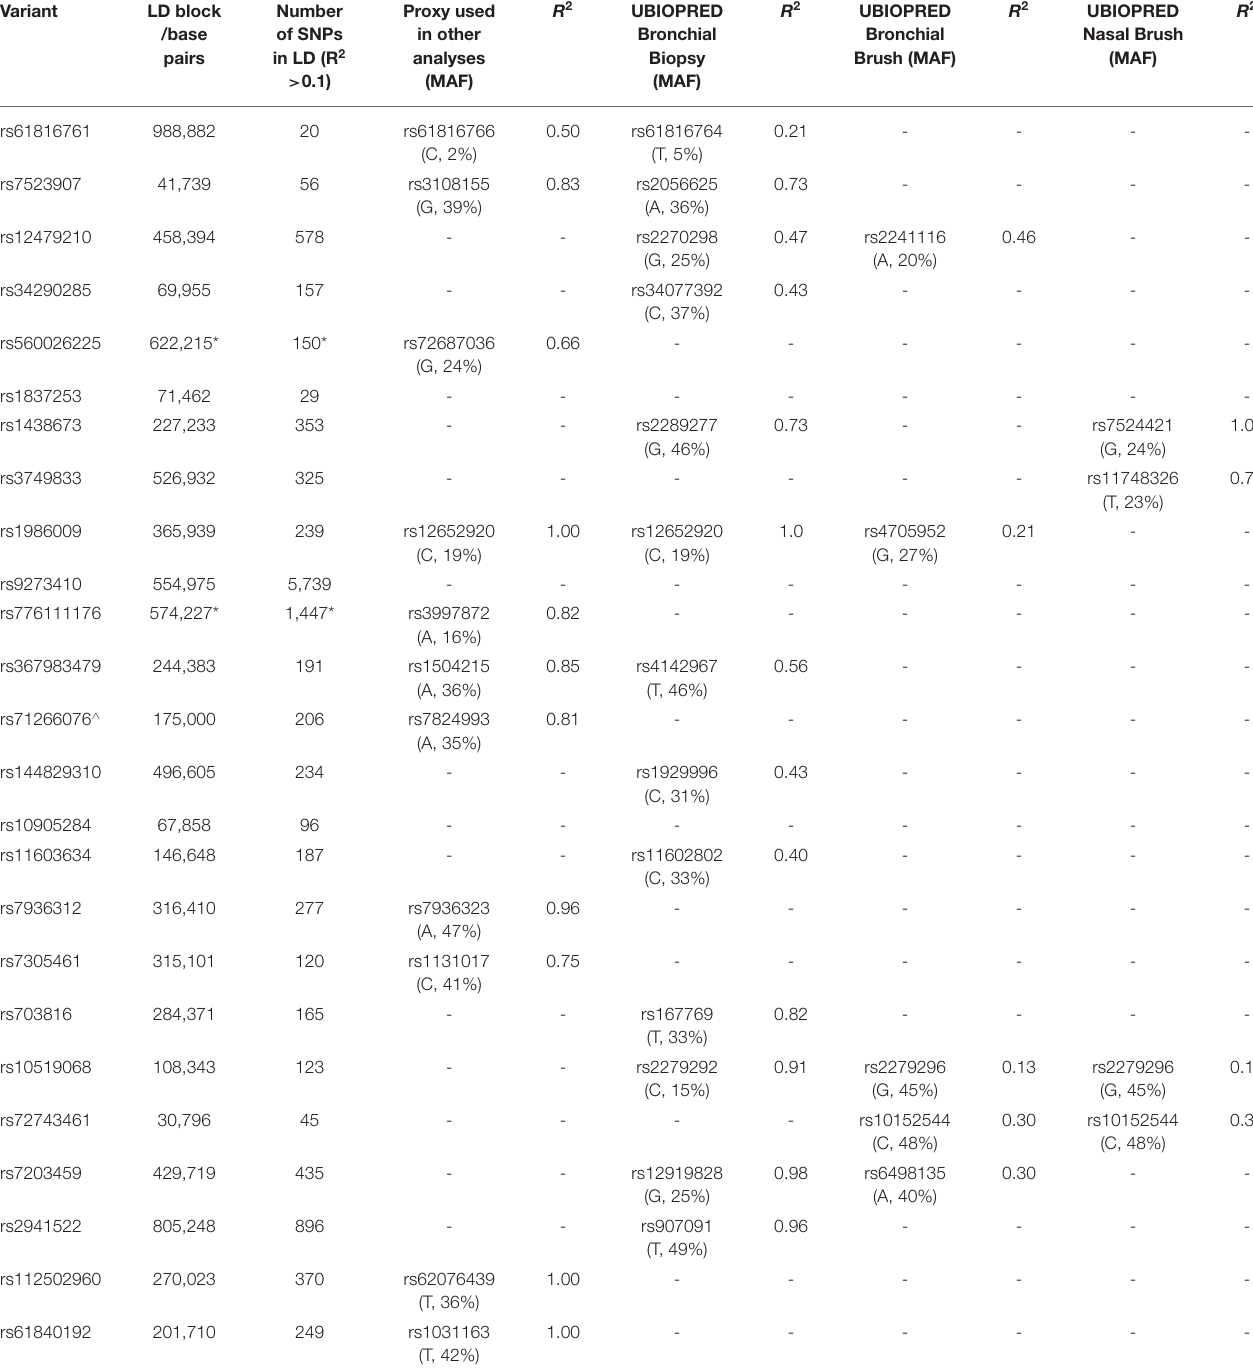
TABLE 2 | SNPs utilized in pipeline